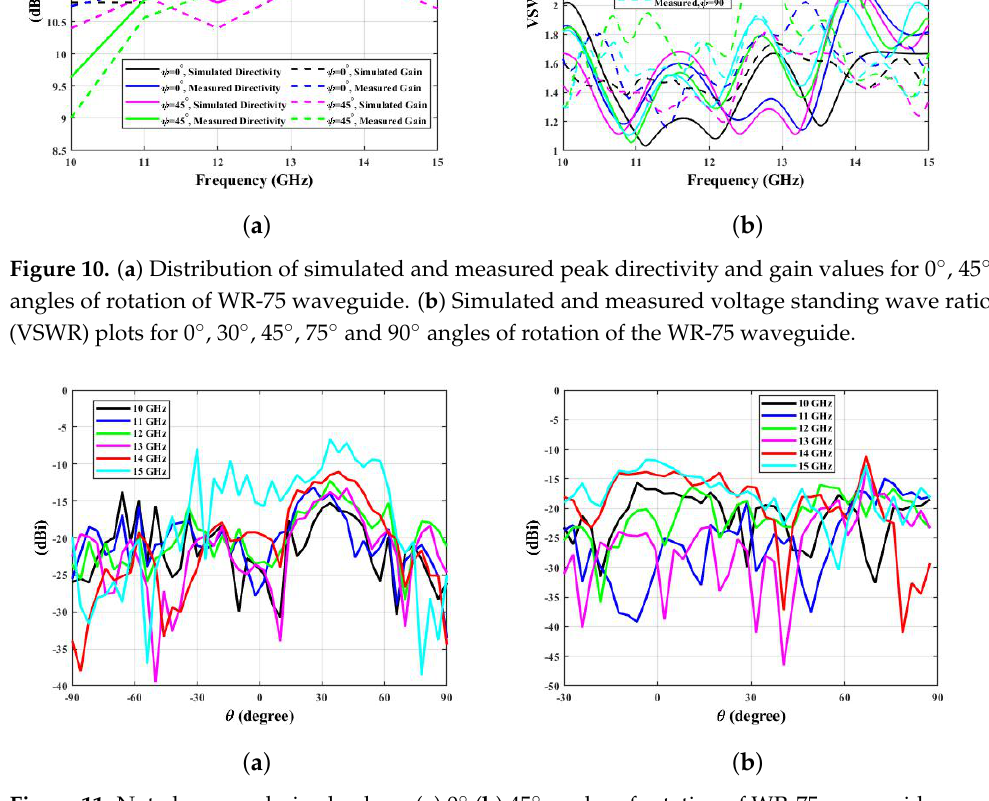
Figure 11. Noted cross polarized values, ( a ) 0 ◦ ( b ) 45 ◦ angles of rotation of WR-75